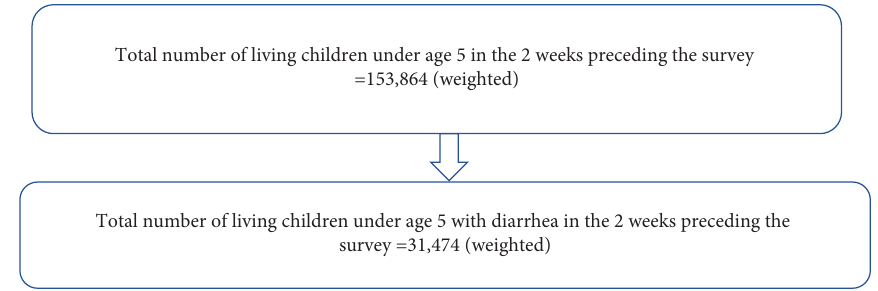
Figure 1: Schematic representation of sampling procedures: evidence from 25 SSA countries